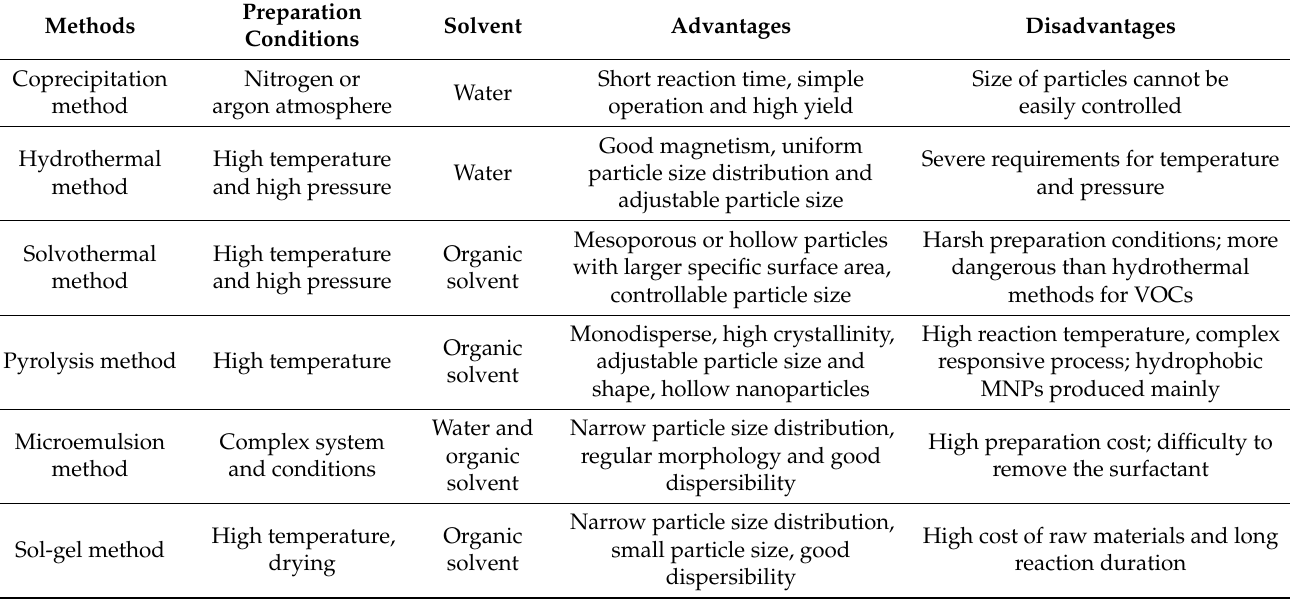
Table 1. The comparison of the preparation methods of Fe 3 O 4 magnetic